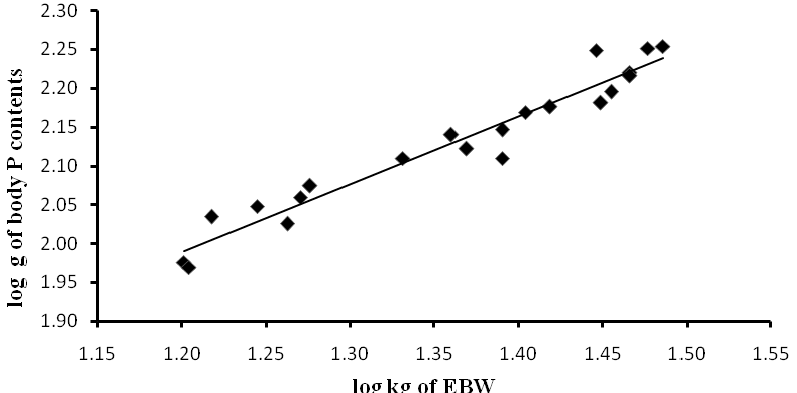
Figure 2. Relationship between body P contents and EBW of Dorper  thin-tailed Han crossbred ram lambs. Log (body P contents, g) = 0.938(  0.068)+0.876(  0.049)  log (EBW, kg) (RMSE = 0.022; p<0.0001; r 2 = 0.943; n =